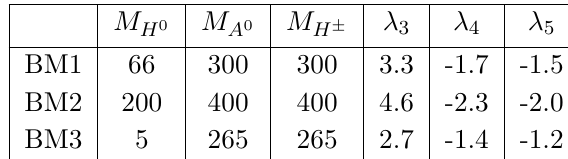
Table 2. Input parameters for the three benchmark scenarios given in ref. [55]. Masses are in unit GeV . Couplings ( λ ) are valued at scale Q = 246 GeV with finite temperature correction. 3 , λ 4 , λ 5